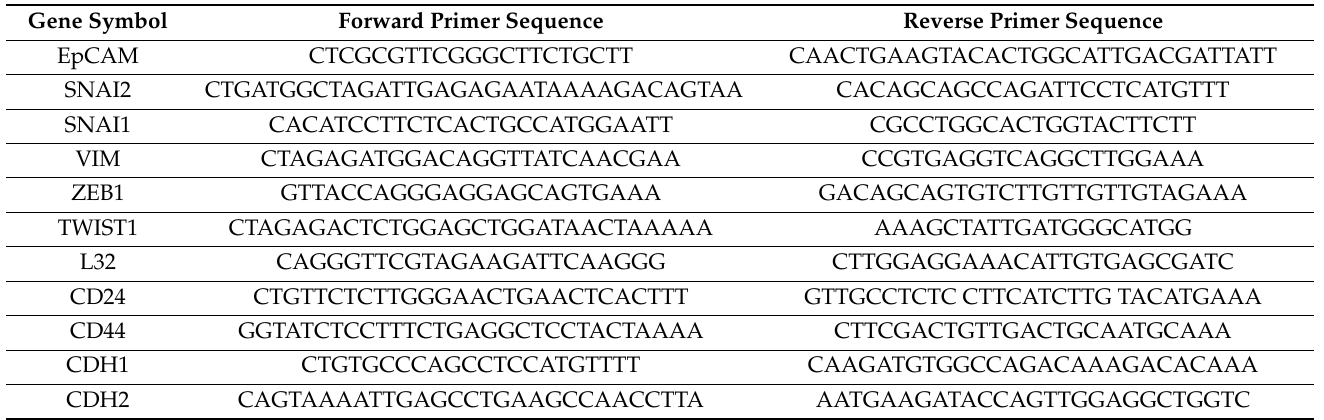
Table 1. The primer sequences of targeted